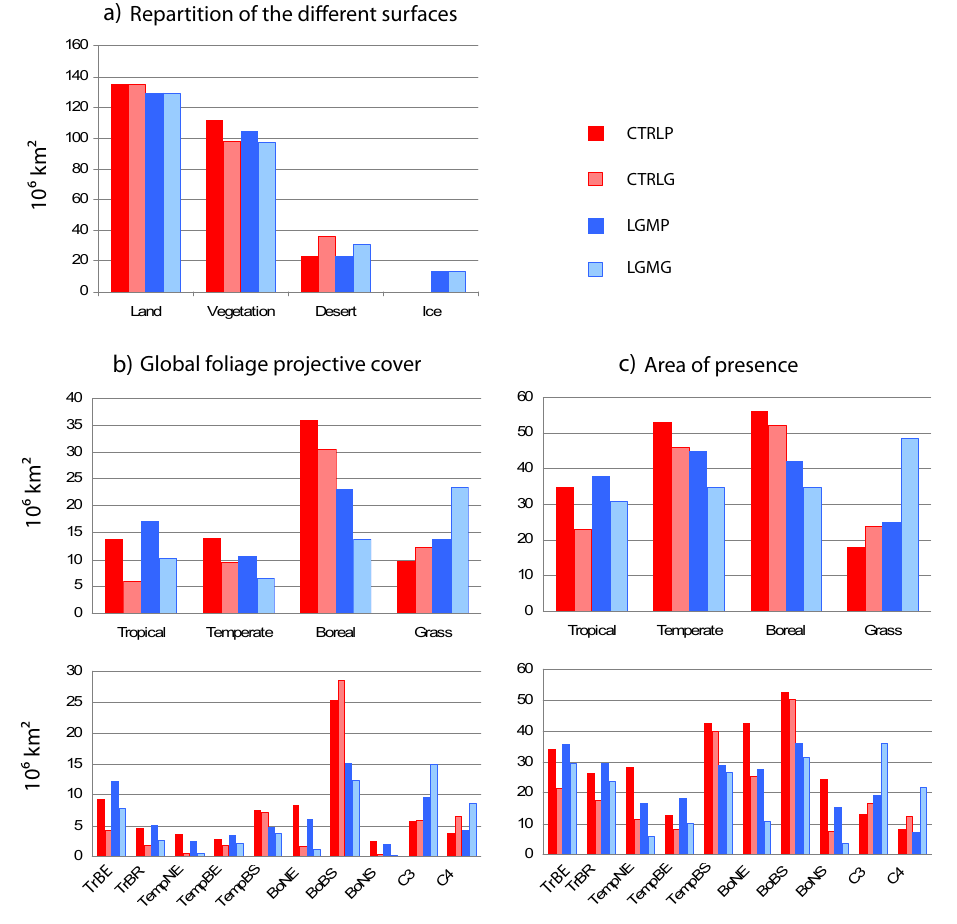
Fig. 8. (a) Repartition of the different surfaces: “Land” is the area available for vegetation (and therefore does not comprise the land area covered by ice); “Vegetation” is the area where the fraction of total vegetation is above 1%; “Desert” is the area where the bare soil fraction exceeds 99%; and “Ice” is the surface of the Laurentide and Fennoscandian ice-sheet present in LGMP and LGMG. (b) Area of annual maximum global foliage projective cover (10 6 km 2 ). (c) Area of presence (10 6 km 2 ) for the different PFTs. A PFT is considered to be present on a grid-cell when its fraction exceeds 1%. The area of presence is thus greater than the surface really covered by a PFT. CTRLP: present climate and modern CO 2 ; CTRLG: present climate and glacial CO 2 ; LGMP: LGM climate and modern CO 2 ; LGMG: LGM climate and glacial CO 2 . Tropical: TrBE+TrBR; Temperate: TempNE+TempBE+TempBS; Boreal: BoNE+BoBS+BoNS; Grass: C3+C4. Abbreviations: see Table